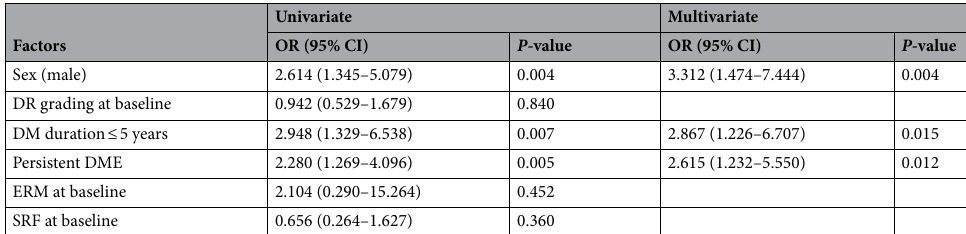
Table 3. Univariate and multivariate regression analysis of clinical characteristics associated with lost to follow-up. DR; diabetic retinopathy, DM; diabetes mellitus, DME; diabetic macular edema, ERM; epiretinal membrane, SRF; subretinal